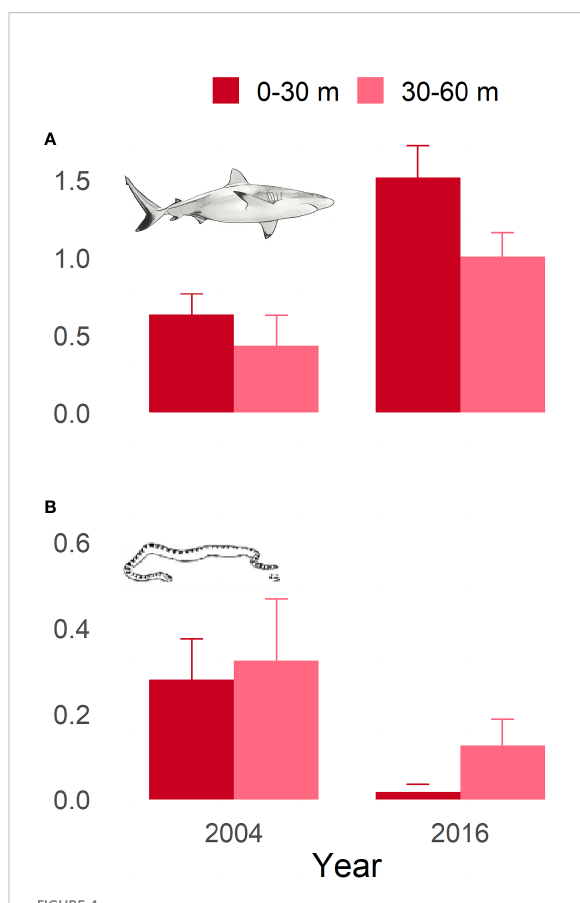
FIGURE 4 Mean hourly observations collected using BRUVS at Ashmore Reef by shallow (< 30 m) and deep (30 – 60 m) habitats for (A) reef sharks and (B) sea